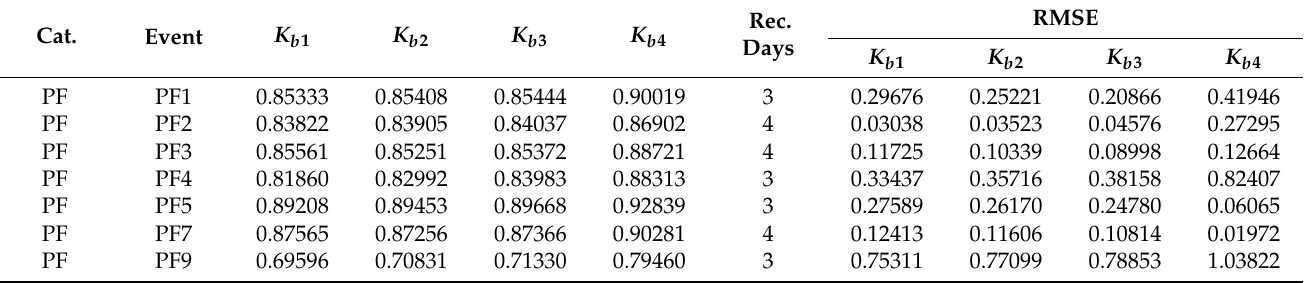
Table A1. Baseflow recession constants produced via different estimation methods ( K b 1 , K b 2 , K b 3 , K b 4 ) and their respective root-mean-squared-error (RMSE) in catchments of differing